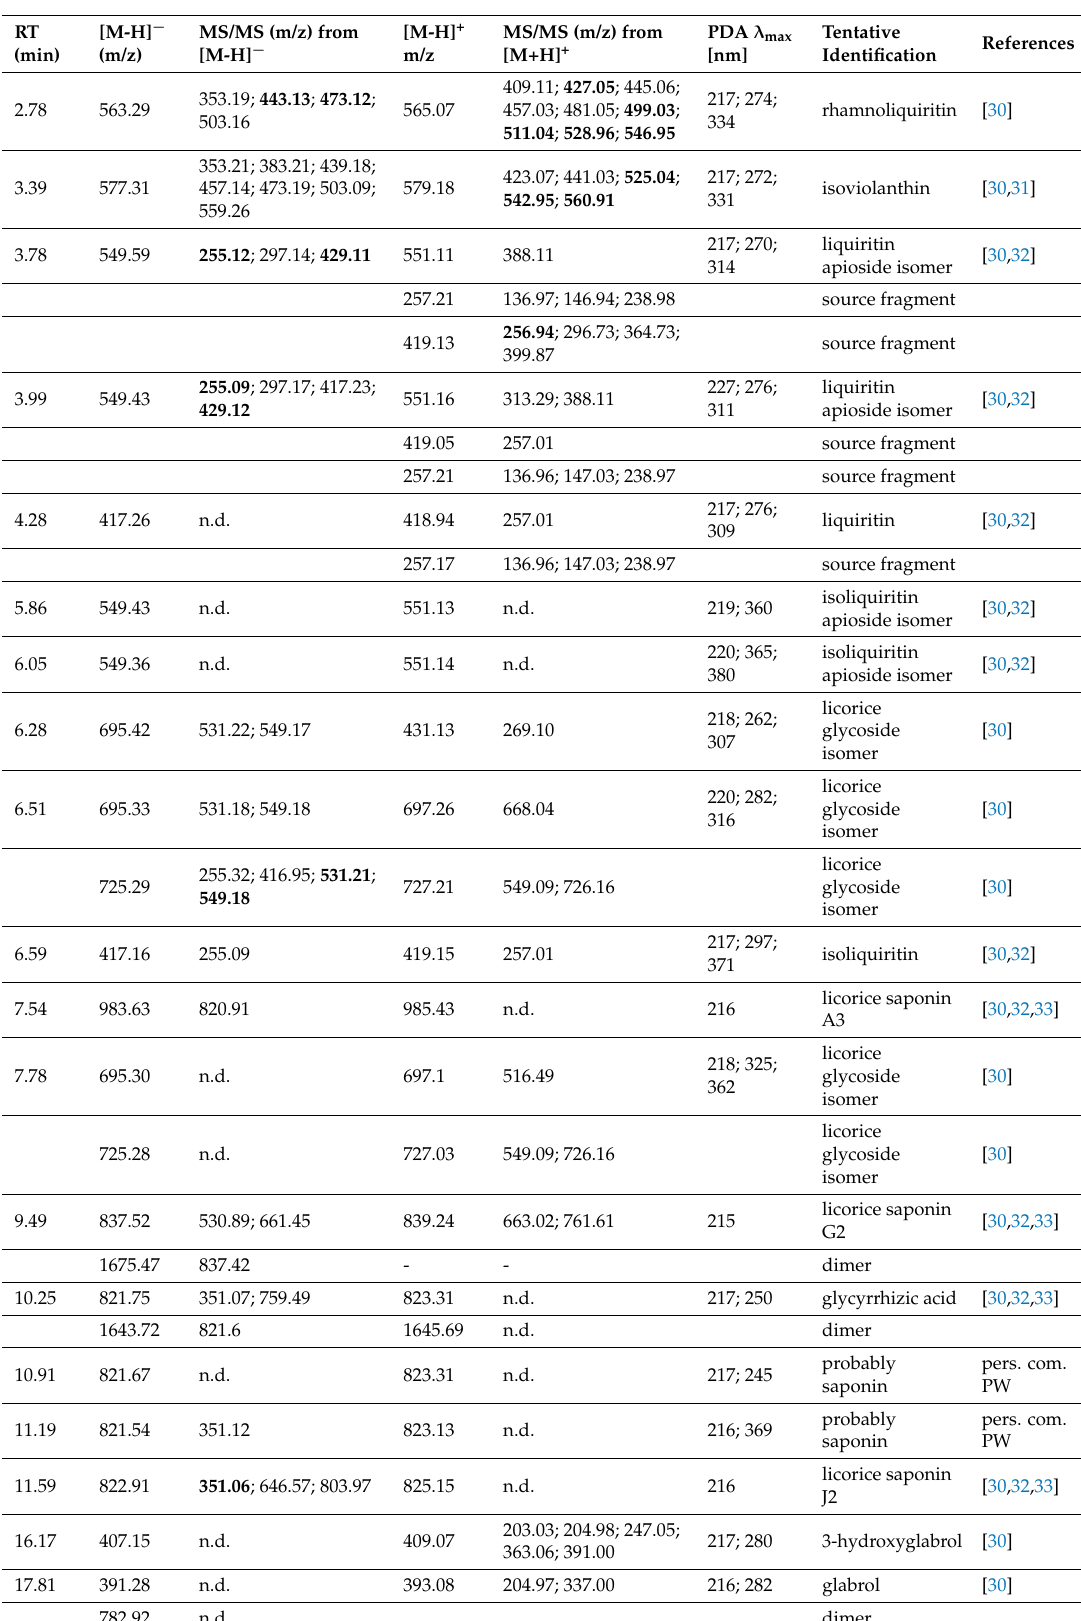
Table 1. Retention times (RT), MS data, and tentatively identified compounds in the G. glabra